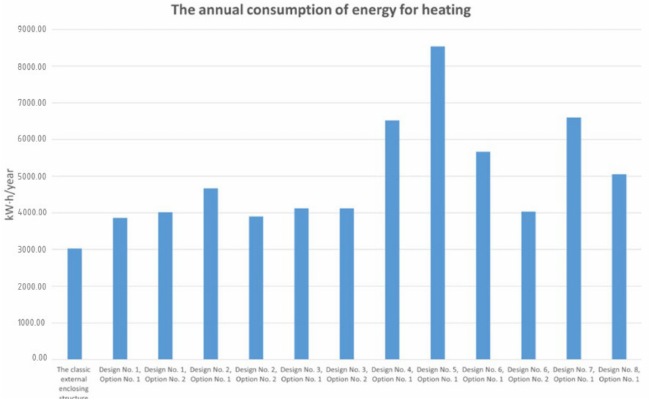
Figure 18. The annual consumption of energy for heating.